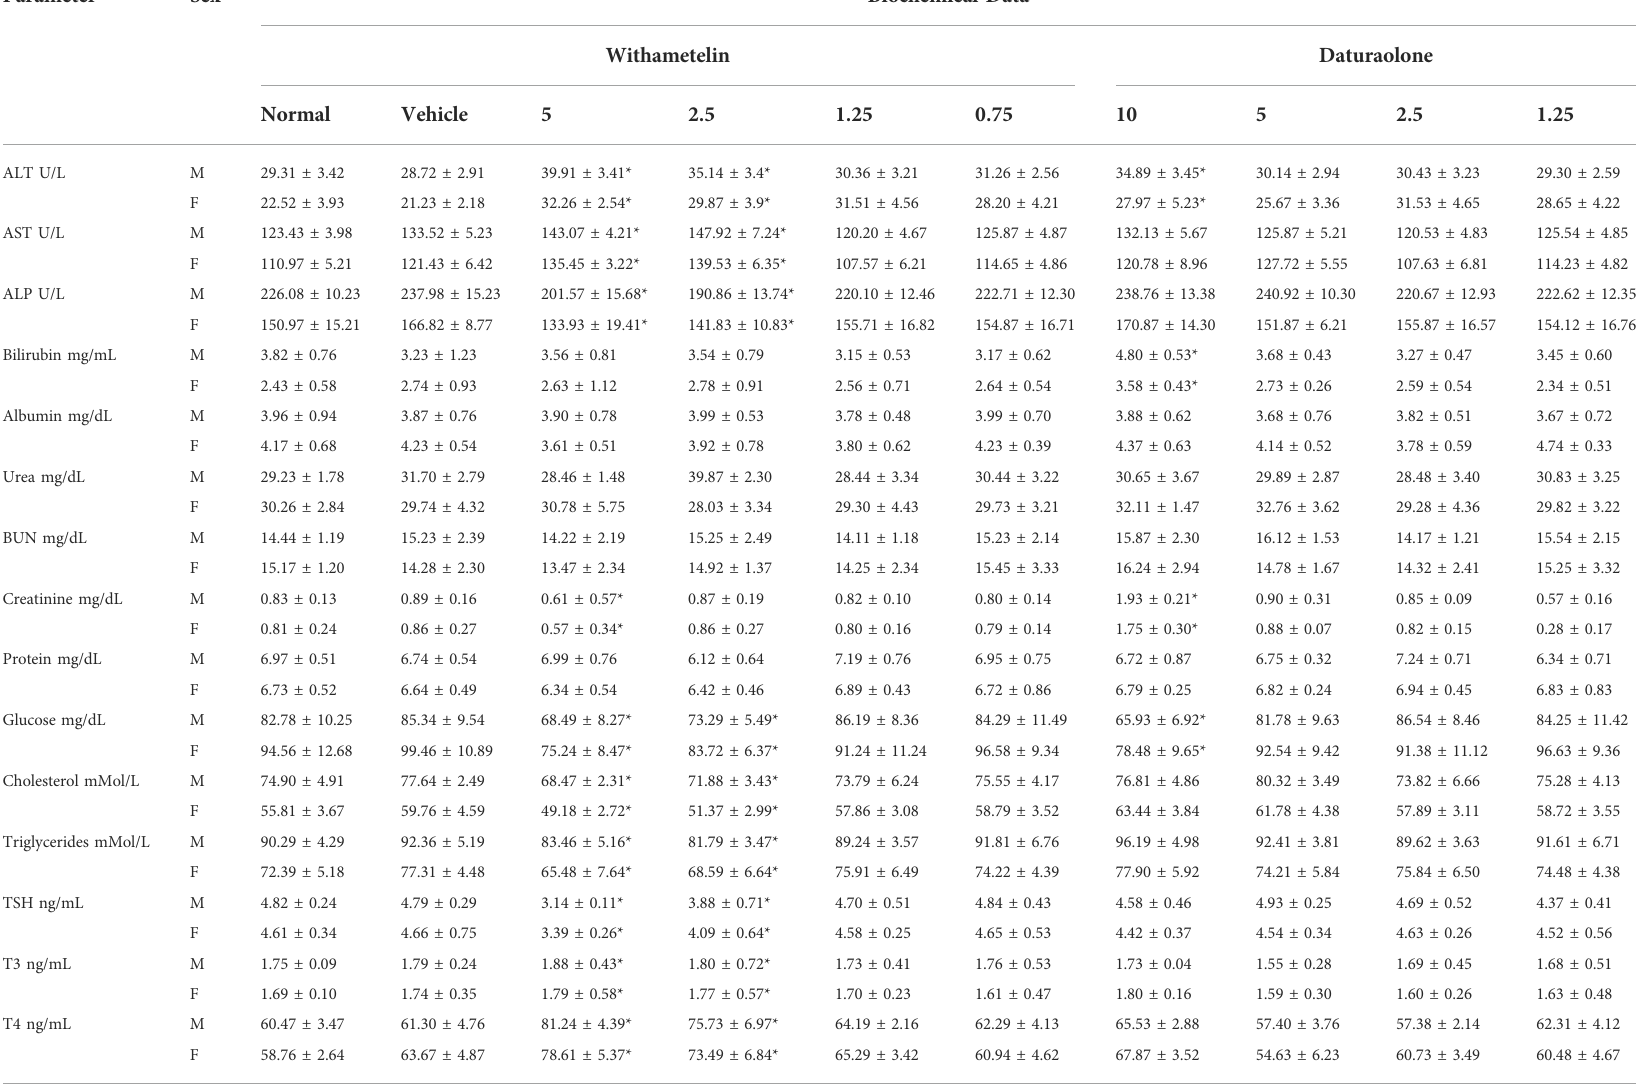
TABLE 4 Serum clinical chemistry of rats sacri fi ced after 28-days repeated oral dose toxicity evaluation.